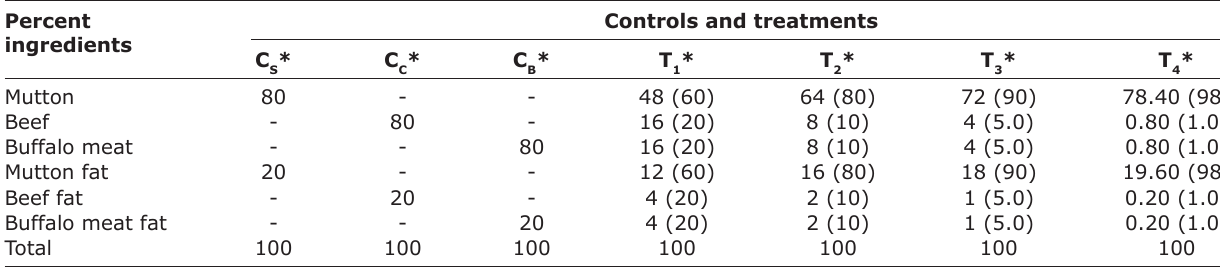
Table-2: Proportions of meat and fat used in the formulation for Rista . Percent